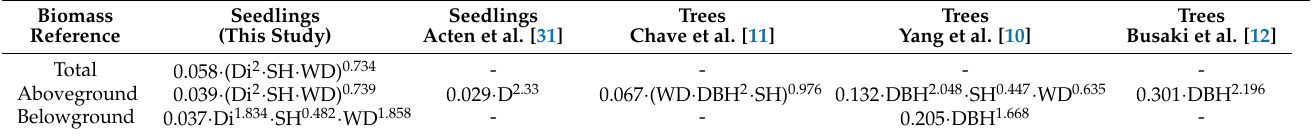
Table 3. Compared allometric models for predicting biomass with other studies